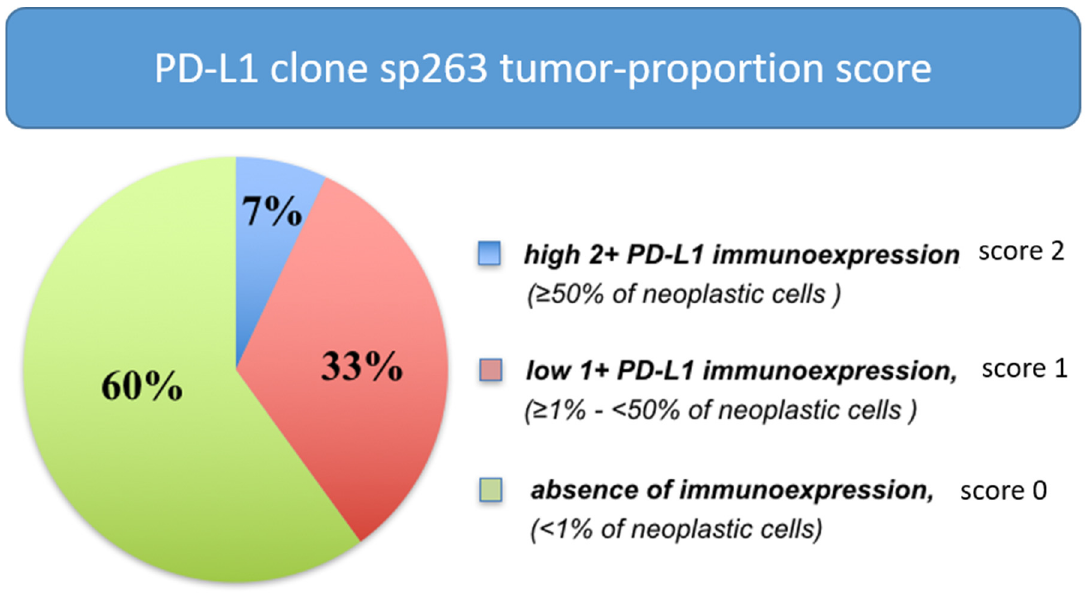
Figure 6. Distribution of PD-L1 immunohistochemical expression in clear cell RCCs after 3D fusion multisite tumor sampling.